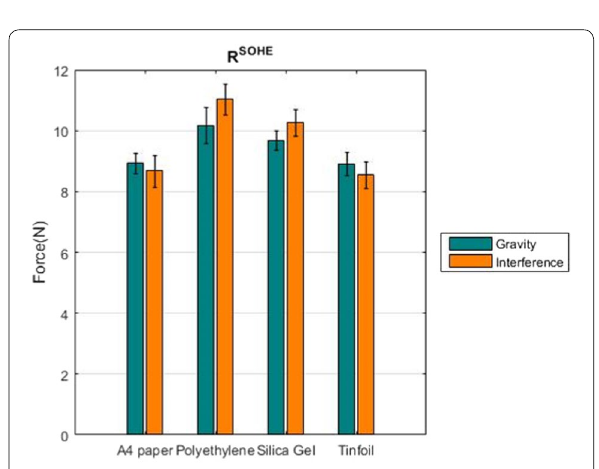
Figure 10 Grasping ability of SOHE grasping mode